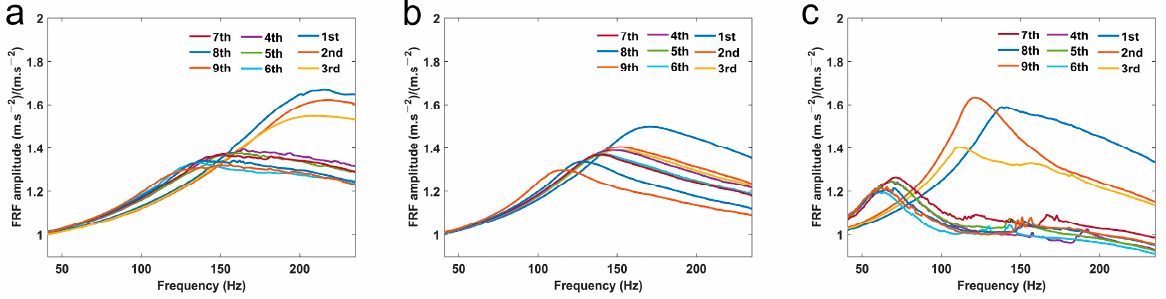
Figure 8. FRF based on different excitations under random vibration: ( a ) 50 g; ( b ) 60 g; ( c ) 70 g. In order to elucidate the fatigue lifetime decay of elastic rubber isolators with random vibration, the functions of the mean value of random acceleration and the stiffness decay